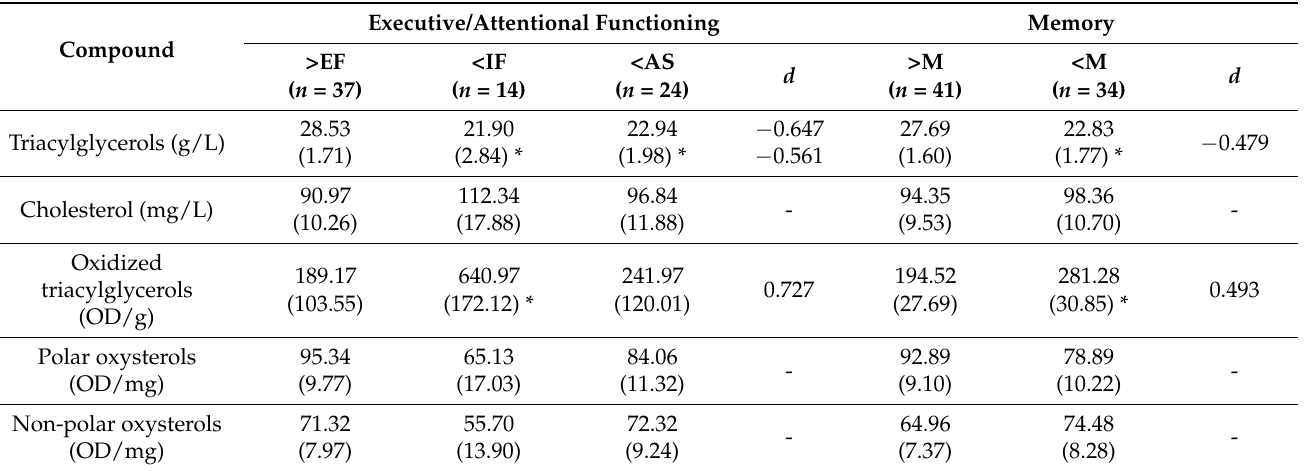
Table 6. Human milk lipids concentration according to executive/attentional functioning and memory of postpartum women from C ó rdoba, Argentina ( n =